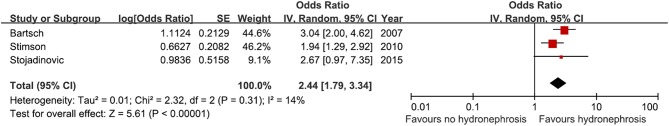
Forest plot and meta-analysis of lymph node invasion after radical cystectomy according to preoperative hydronephrosis. SE, standard error; IV, inverse variance; CI, confidence interval; df, degrees of freedom.